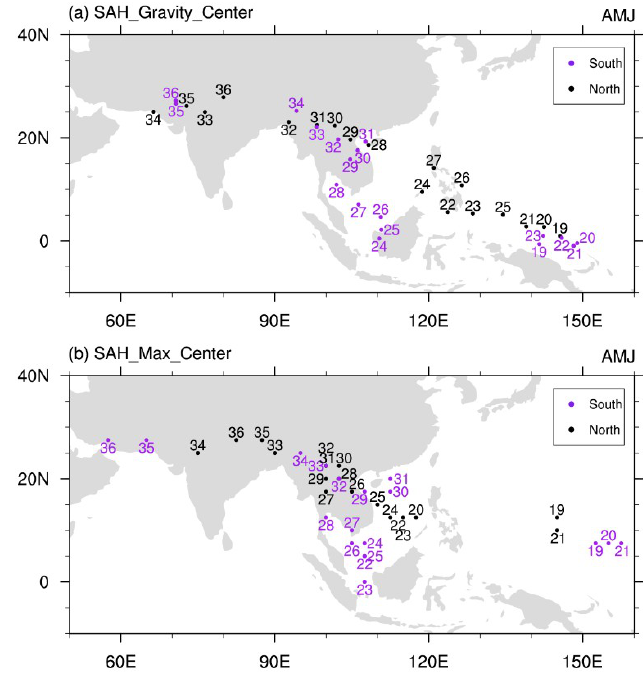
Figure 5. Locations of ( a ) SAH gravity centers and ( b ) SAH maximum center from Pentad 19 to Pentad 36 in the North (black dots) and South (purple dots) track cases. Black and purple numbers indicate the pentads in the North and South track cases, respectively.